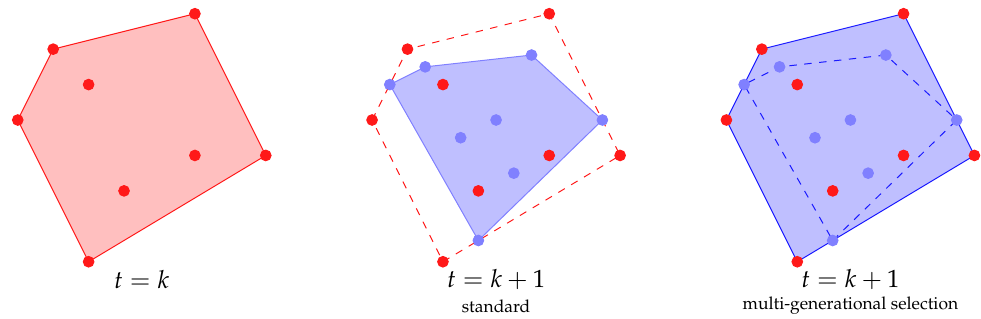
Figure 1. A representation of the effect of multi-generational selection on the convex hull where geometric semantic crossover can generate new